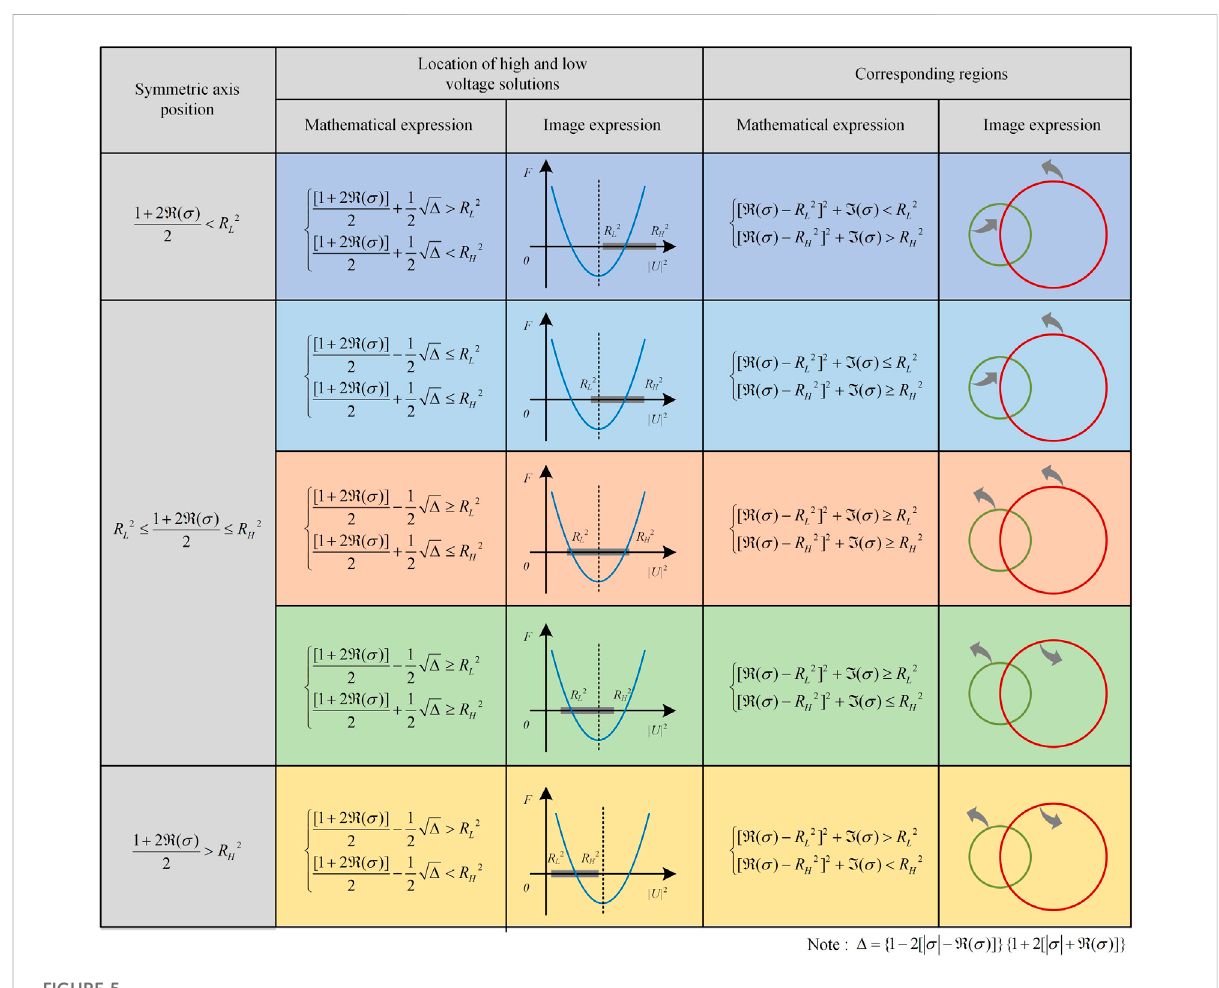
FIGURE 5 Voltage constraint region partitioning